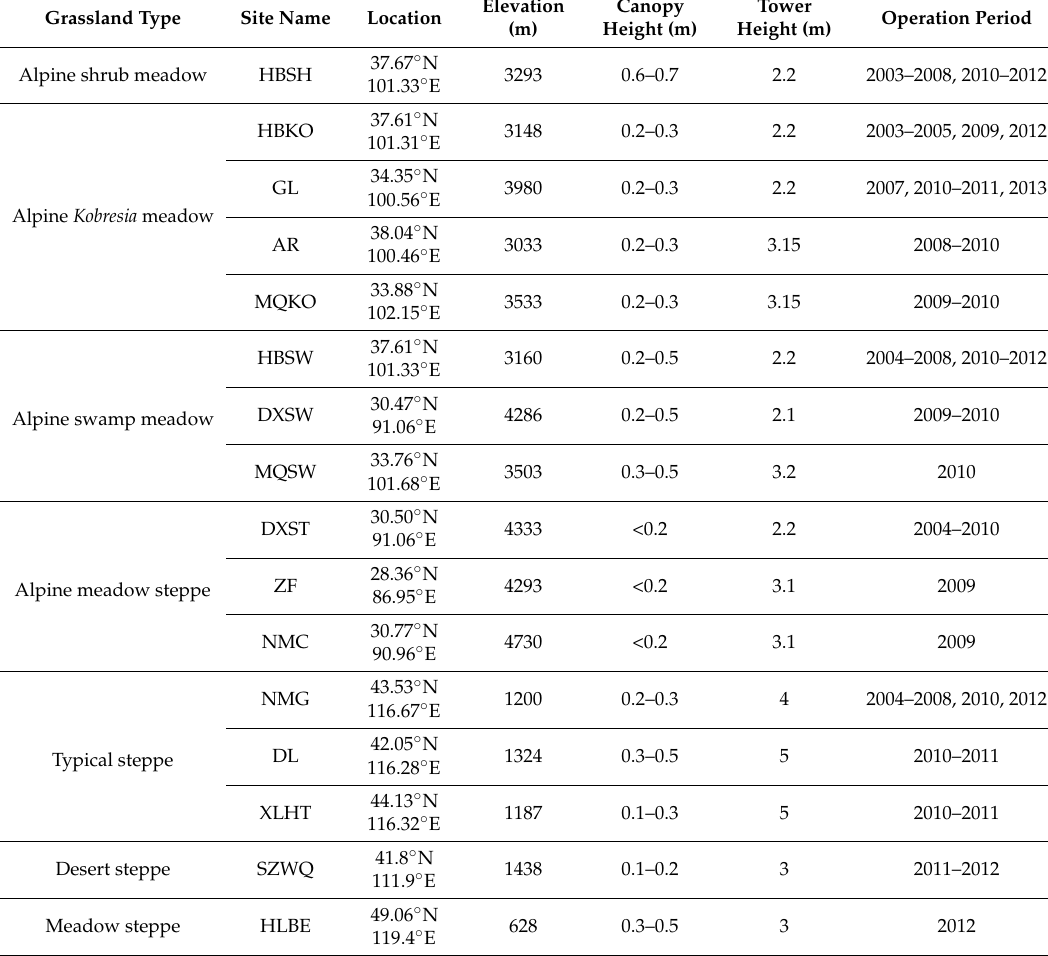
Table 1. Main characteristics of the 16 flux-tower sites over China’s